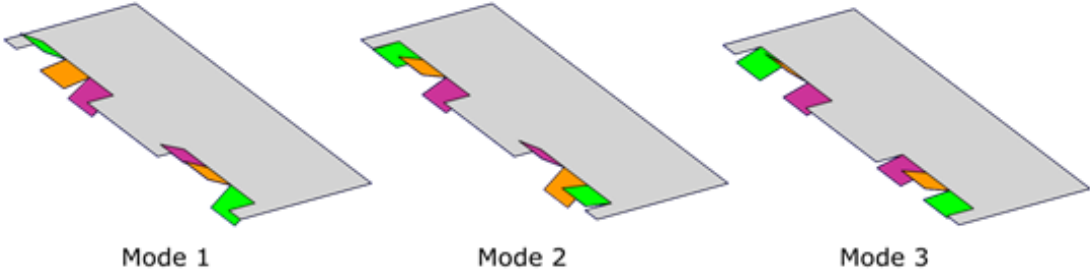
Figure 4. Visualisation of null space vectors for an untapered straight wing. Any linear combination of the three modes will ensure that the constraints on lift, pitching moment and rolling moment are satisfied whilst producing a yawing moment. Defections are exaggerated for